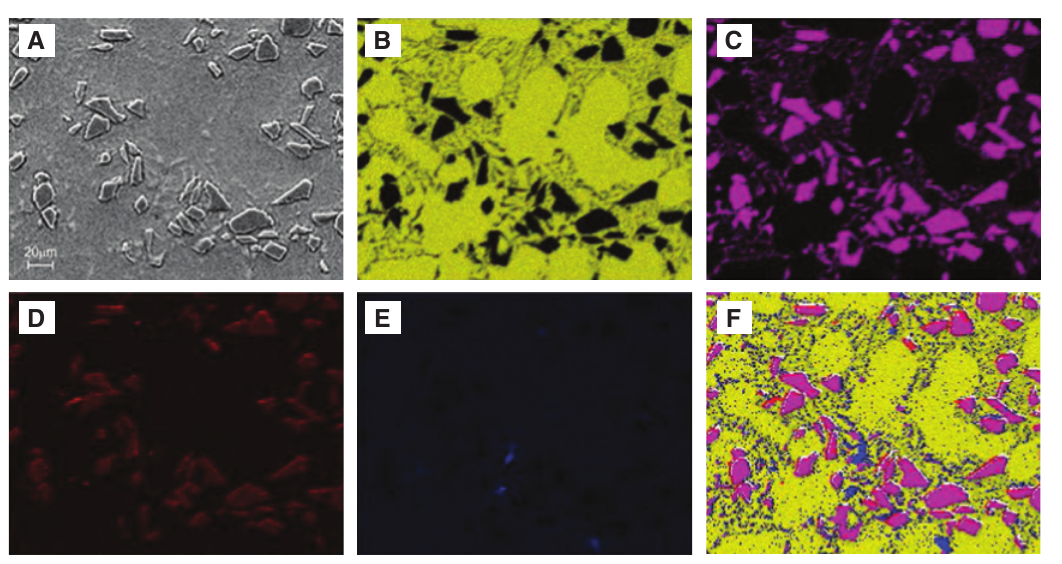
Figure 5 A typical SEM micrograph of the Al foam showing dendritic structure with well-dispersed reinforcement particles and its EDX element mapping results: (A) an SEM micrograph, and element mapping results of (B) Al, (C) Si, (D) C, (E) Mg, and (F)